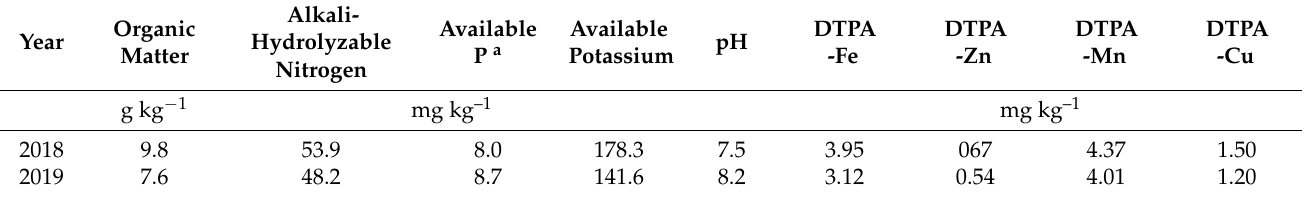
Figure 1. Monthly mean air temperatures and precipitation for 2018, 2019, and the 30-year average at Yongdeng, China. Table 1. General soil properties and DTPA-extractable mineral elements before sowing in 2018 and 2019.